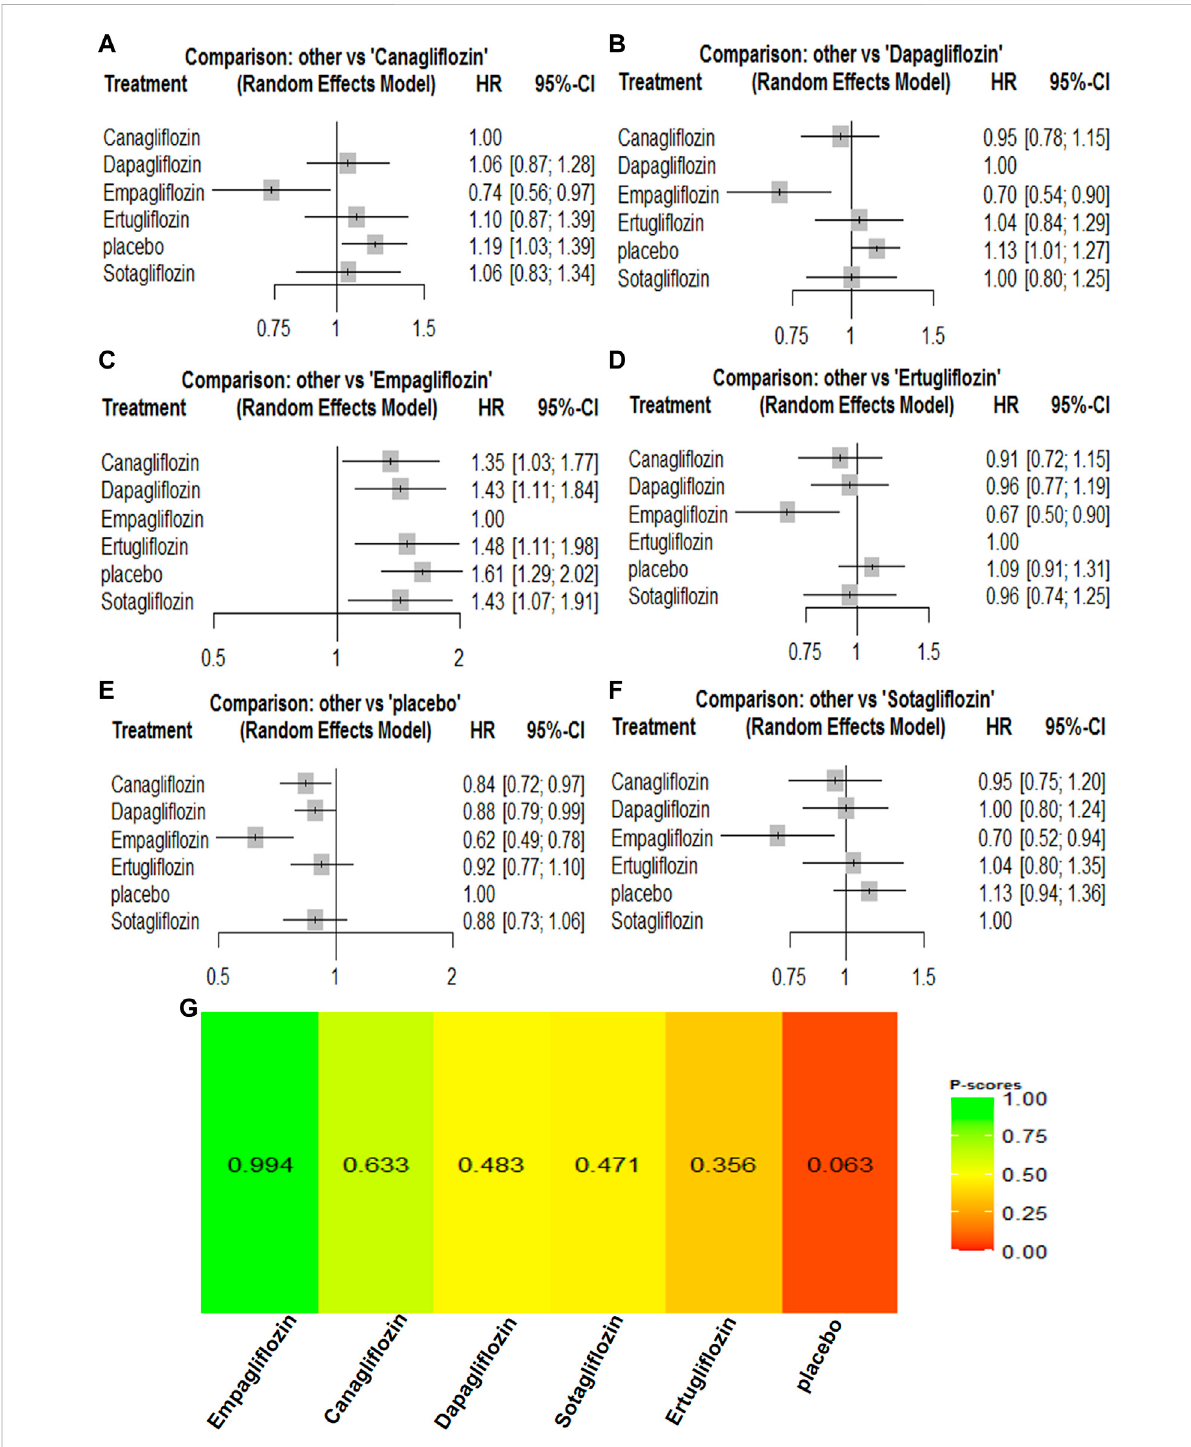
FIGURE 3 Forest Plots and Ranking Plots of Network Meta-analysis of all trials for Cardiovascular Mortality. (A) Forest Plots of other drugs compare to placebo. (B) Forest Plots of other drugs compare to dapagli fl ozin. (C) Forest Plots of other drugs compare to empagli fl ozin. (D) Forest Plots of other drugs compare to ertugli fl ozin. (E) Forest Plots of other drugs compare to canagli fl ozin. (F) Forest Plots of other drugs compare to sotagli fl ozin. All effectestimatesareexpressedashazardratios(HRs)fortreatmentvsthecomparatorand95%credibleintervals(95%-CI).Forexample,theHRs in cardiovascular mortality for dapagli fl ozin compared to canagli fl ozin is 1.06 (95%-CI 0.87 to 1.28). The x-axis scale indicates the range of the HRs. (G) Ranking Plots of Network Meta-analysis. Plots below the forest plots show for the rank of each drug class and ranking descending from left to right, The p-score represents the power of the